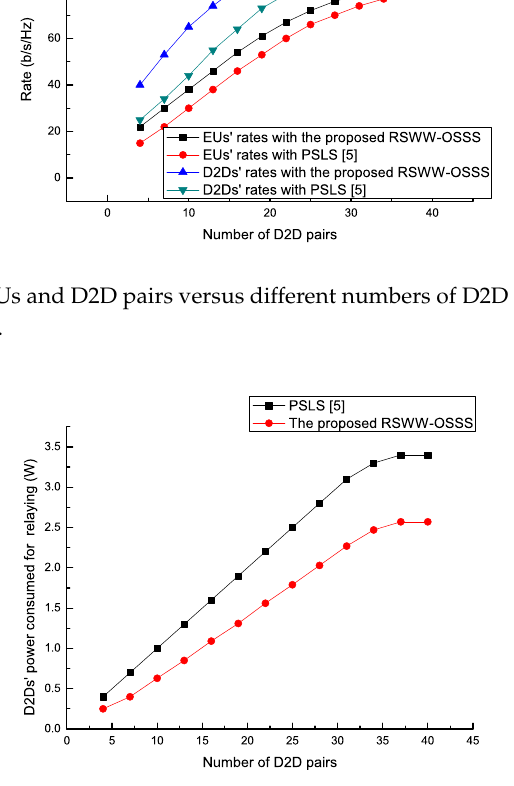
Figure 4. D2D pairs consumed power for relaying data versus different numbers of D2D transmission pairs when the number of EUs is